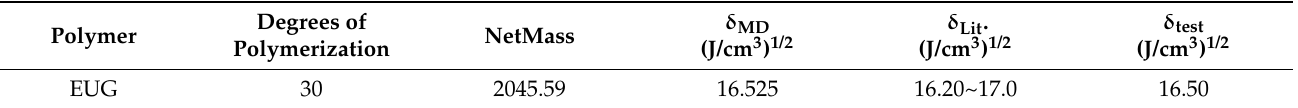
Figure 9. MD simulated and experienced values of solubility parameters for different degrees of polymerization of EUG. Table 1. Solubility parameters of EUG with a polymerization degree of